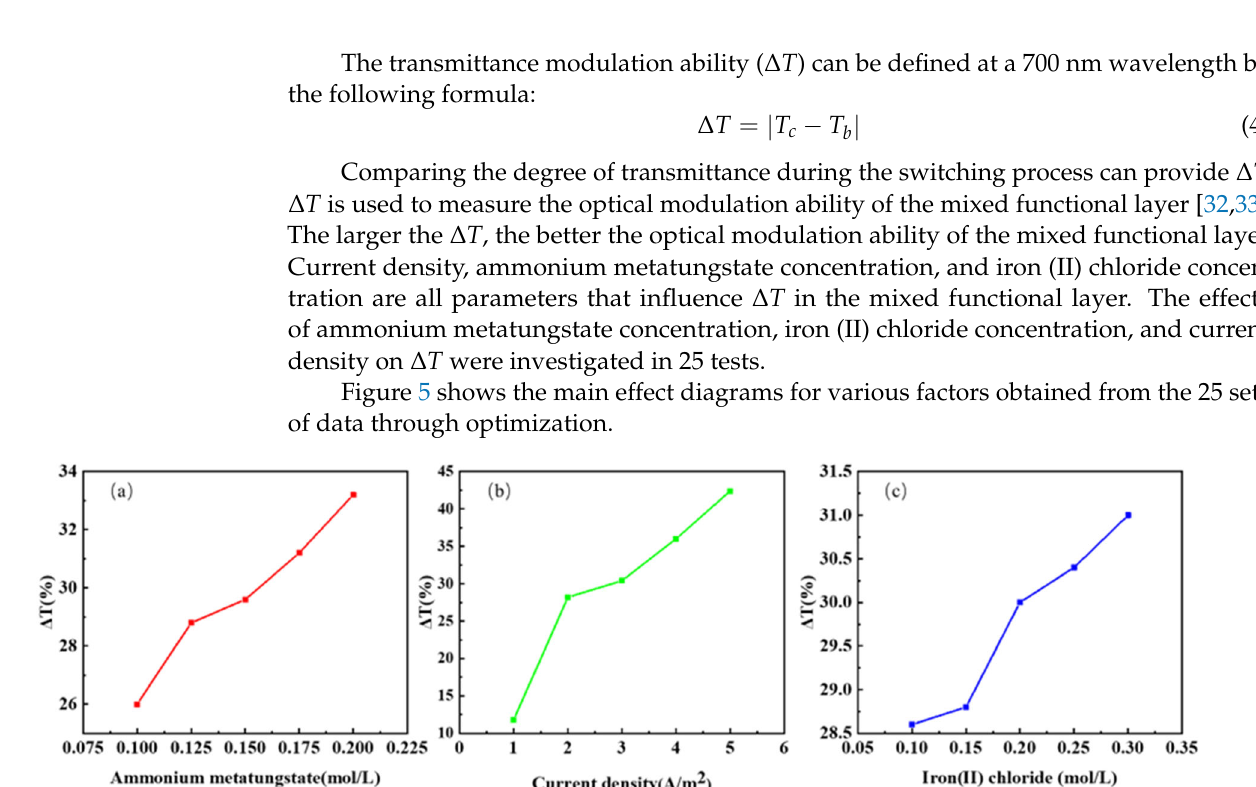
Figure 4. The optical transmittance spectra of the two different samples of the mixed functional layer in the initial, bleached, and colored state: ( a ) 0.175 mol/L ammonium metatungstate × 0.25 mol/L